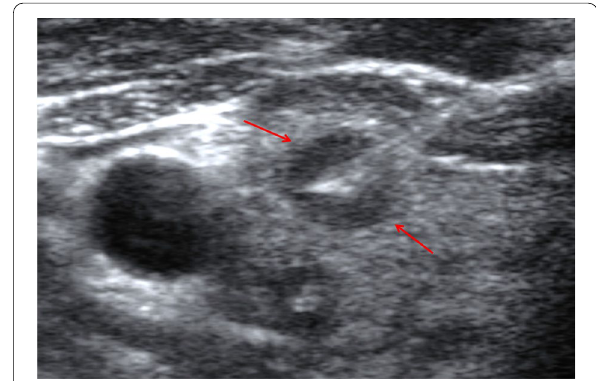
Fig. 5 The ultrasound-guided fine-needle aspiration from a hypoechoic solid nodule with regular margin, punctate echogenic foci, and a diameter of 8 mm (ACR-TIRADS-5, ATA-2015-High suspicion, K-TIRADS-5), which was proved by cytology to be a